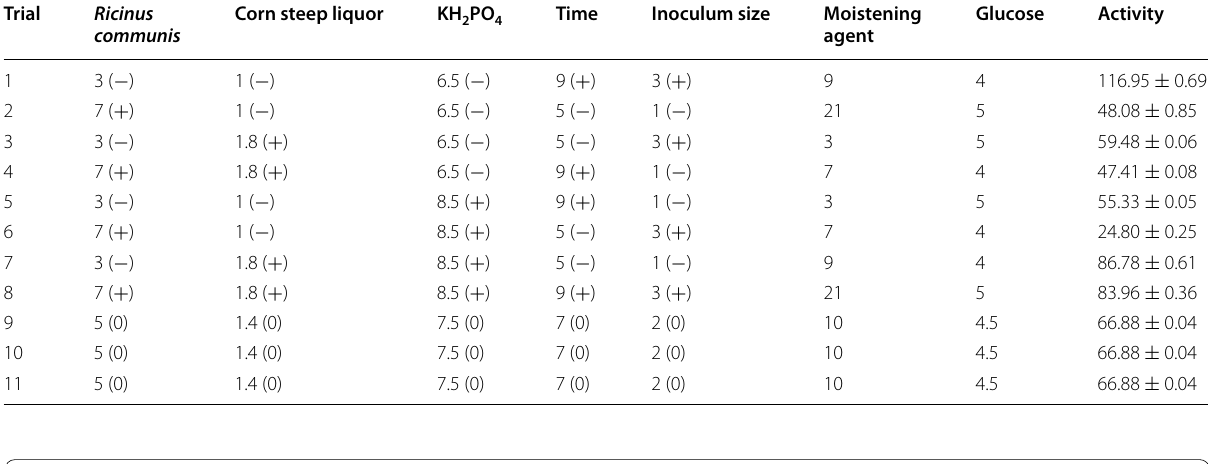
Table 2 Plackett‑Berman experiment coded levels and real values